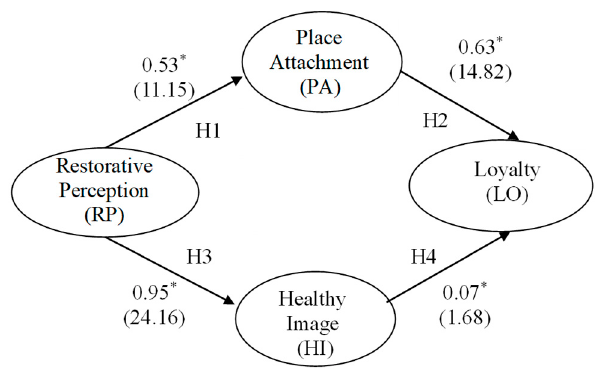
Figure 2. Relationship between variables.